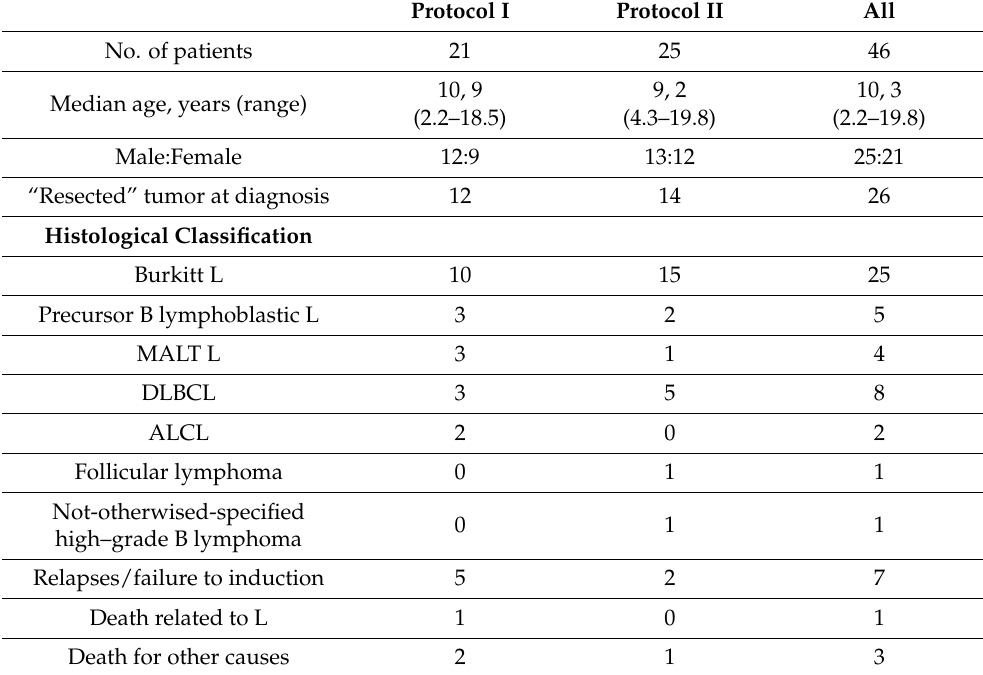
Table 1. Characteristics of